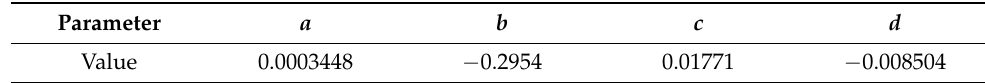
Table 3. Battery internal resistance curve parameters.